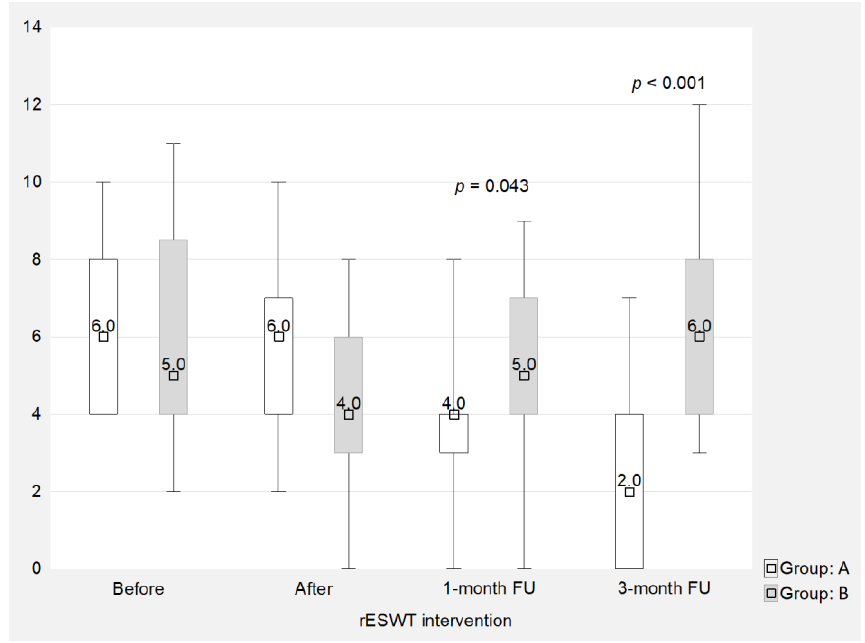
Figure 4. Comparison of pain outcomes (LPS) between two groups (points). LPS: Laitinen Pain Scale.